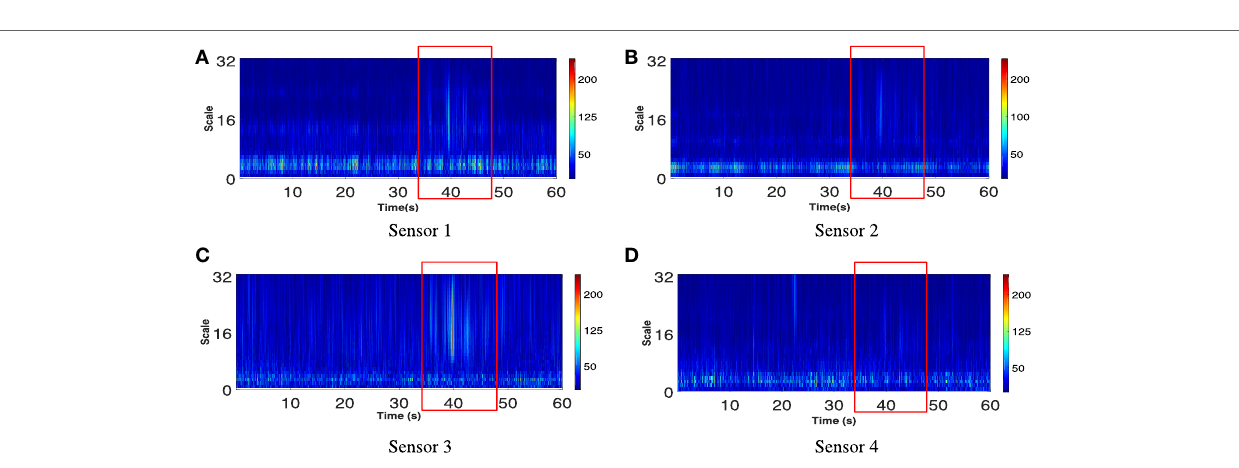
Frontiers in Built Environment |